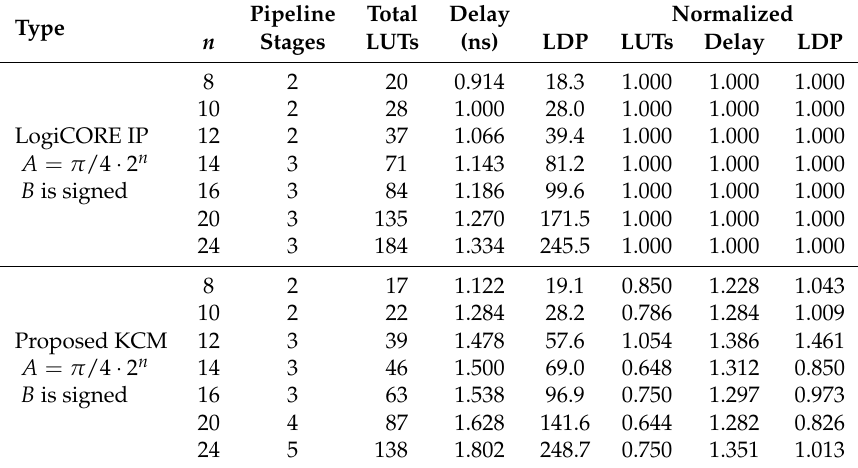
Table 5. Synthesis results for pipelined ( m × n )-bit KCMs, where m = n , A = π /4 · 2 n and B is a signed variable. Proposed KCMs use 22% fewer LUTs on average compared to LogiCORE IP KCMs and the increase in delay is less significant than it is for single-cycle